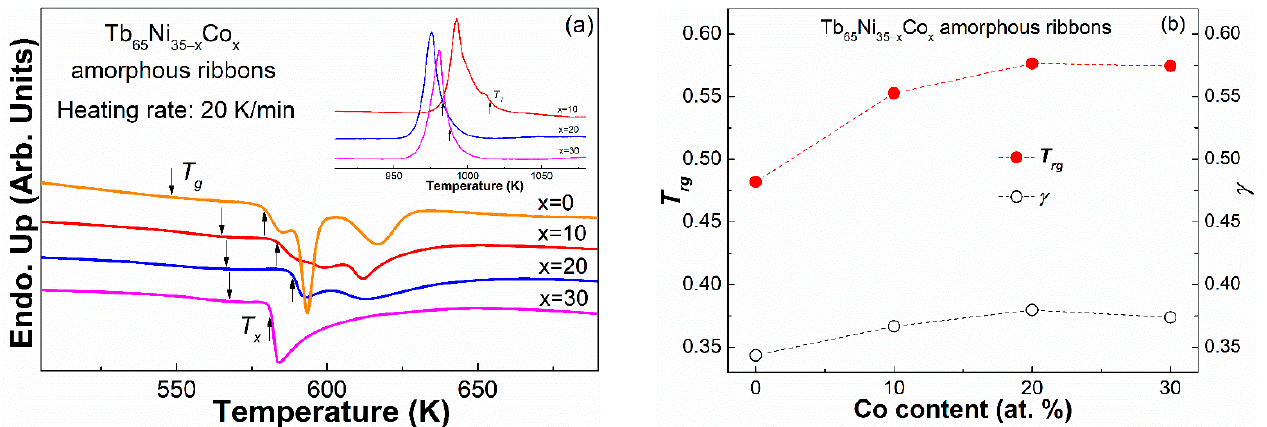
Figure 2. ( a ) DSC curves of the Tb 65 Ni 35 − x Co x (x = 0, 10, 20 and 30) amorphous ribbons at a heating rate of 0.333 K/s, and the inset are the melting behaviors; ( b ) the compositional dependence of T rg and γ for the Tb 65 Ni 35 − x Co x amorphous ribbons. Table 1. Thermal parameters, T rg and γ of the Tb 65 Ni 35 − x Co x (x = 0, 10, 20 and 30) amorphous alloys.